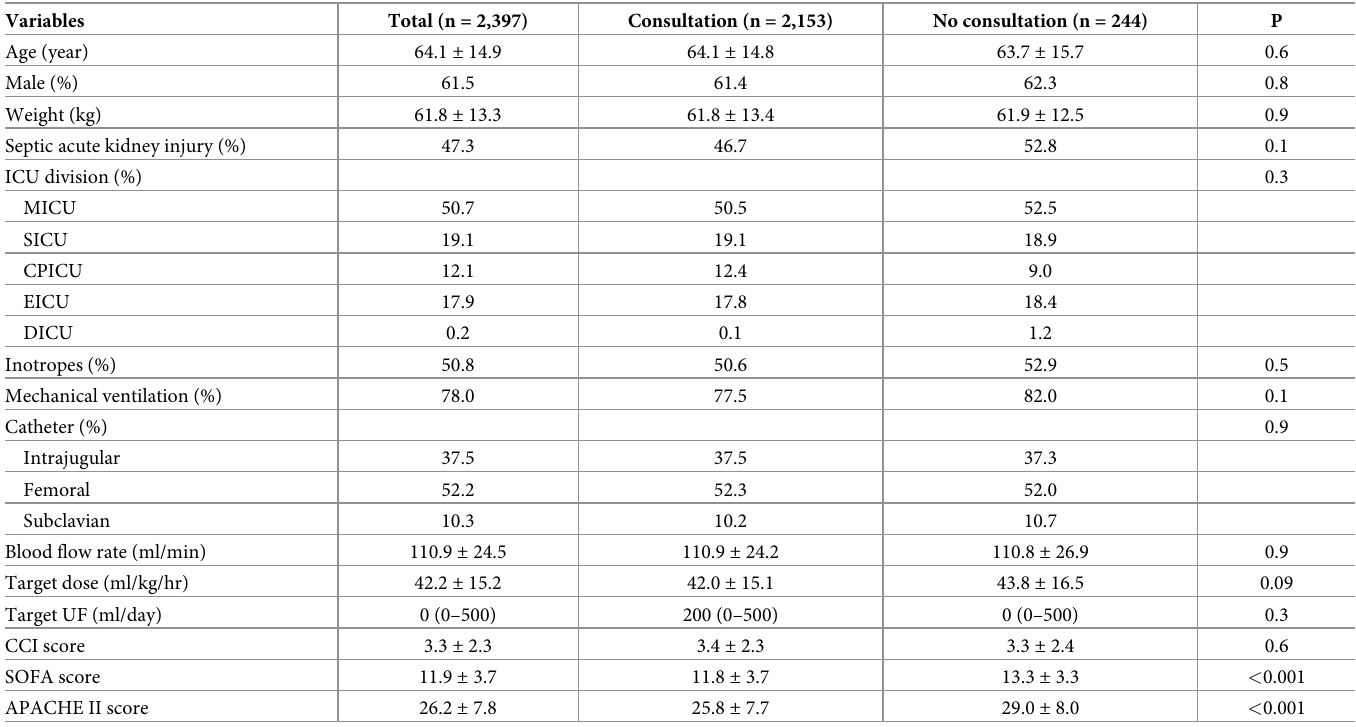
Table 1. Baseline patient